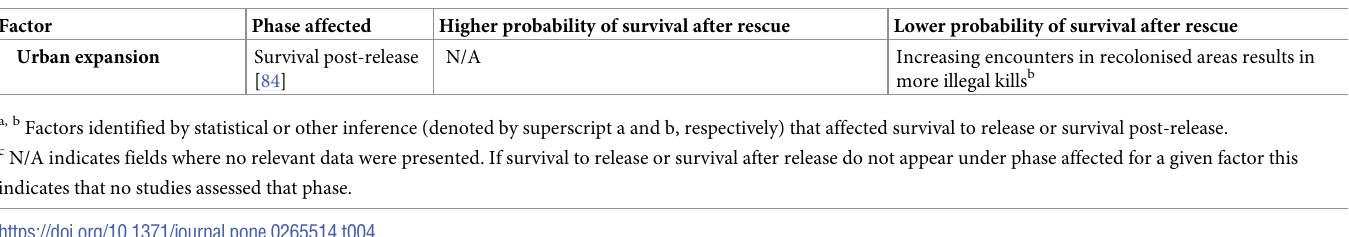
given different treatment regimens [86], allowing the researchers to determine the best treat- ment to reduce future unassisted deaths. The greatest death rate recorded in the review was 61.3% for little penguins ( Eudyptula minor) rescued after an oil spill event in Australia [35]. Most mortalities occurred within the first 12 days, and were attributed to the degree of oiling, the amount of oil ingested, the low body weight of penguins on arrival, and inappropriate